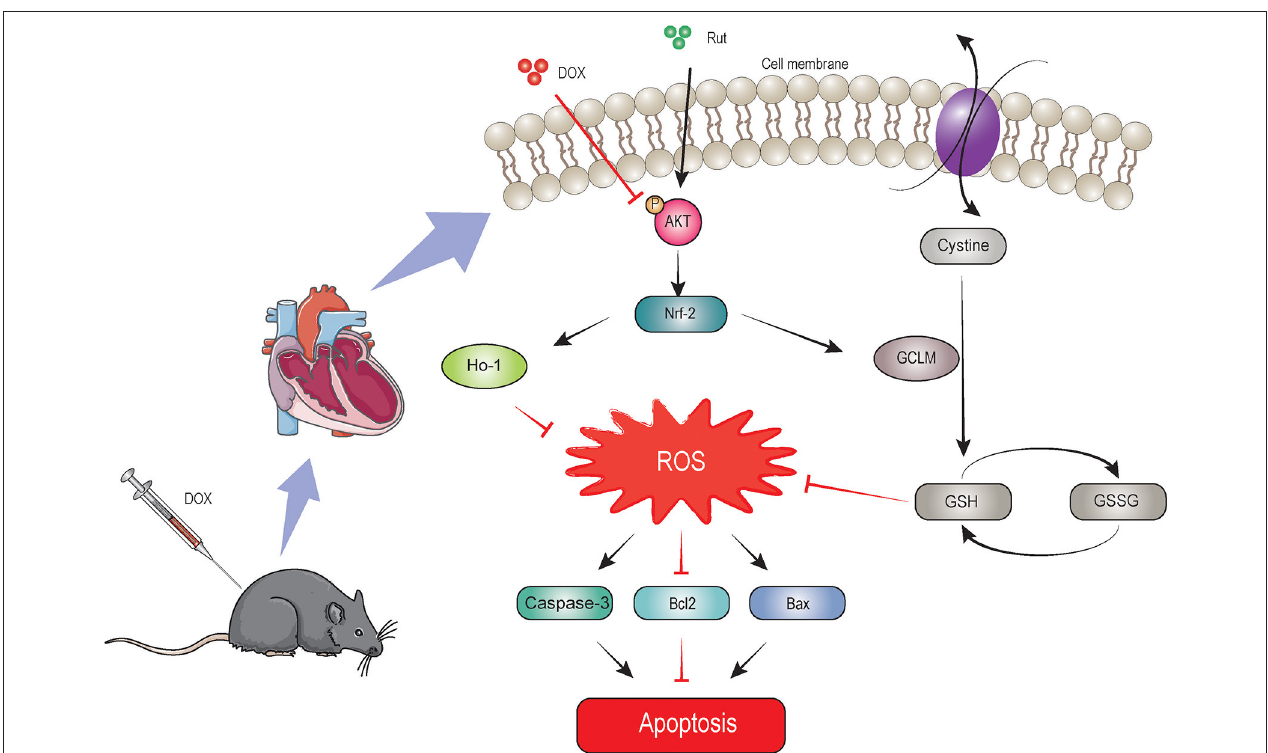
FIGURE 7 | The proposed protective mechanism by rutaecarpine on DOX-induced heart failure. Rutaecarpine activated AKT/Nrf-2 signaling pathway, which in turn inhibited DOX-induced oxidative stress and apoptosis through regulating heme oxygenase-1 (HO-1) and GSH cysteine ligase modulatory subunit (GCLM)